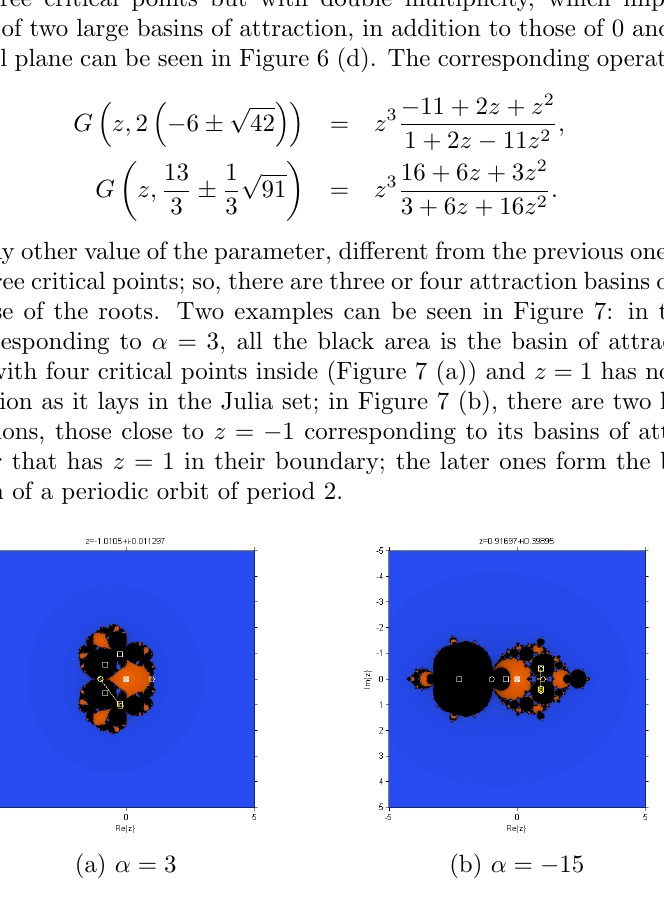
Figure 7. Dynamical planes of the operator G ( z,α ) with four different free critical